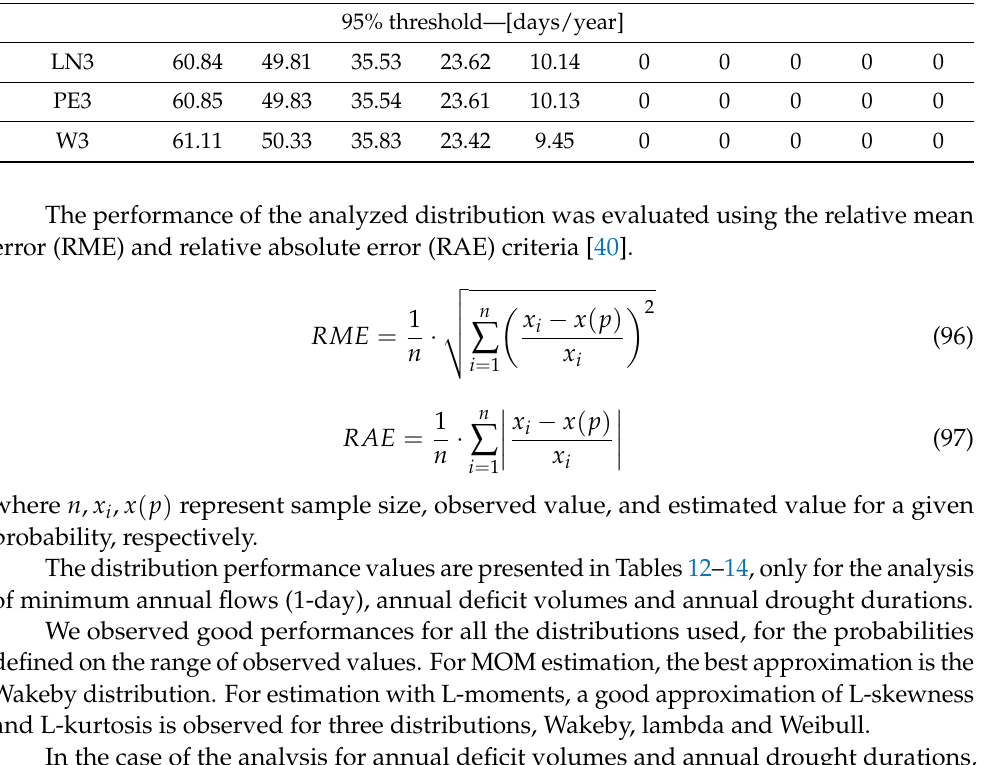
Table 12. Distribution performance values for minimum annual flows.